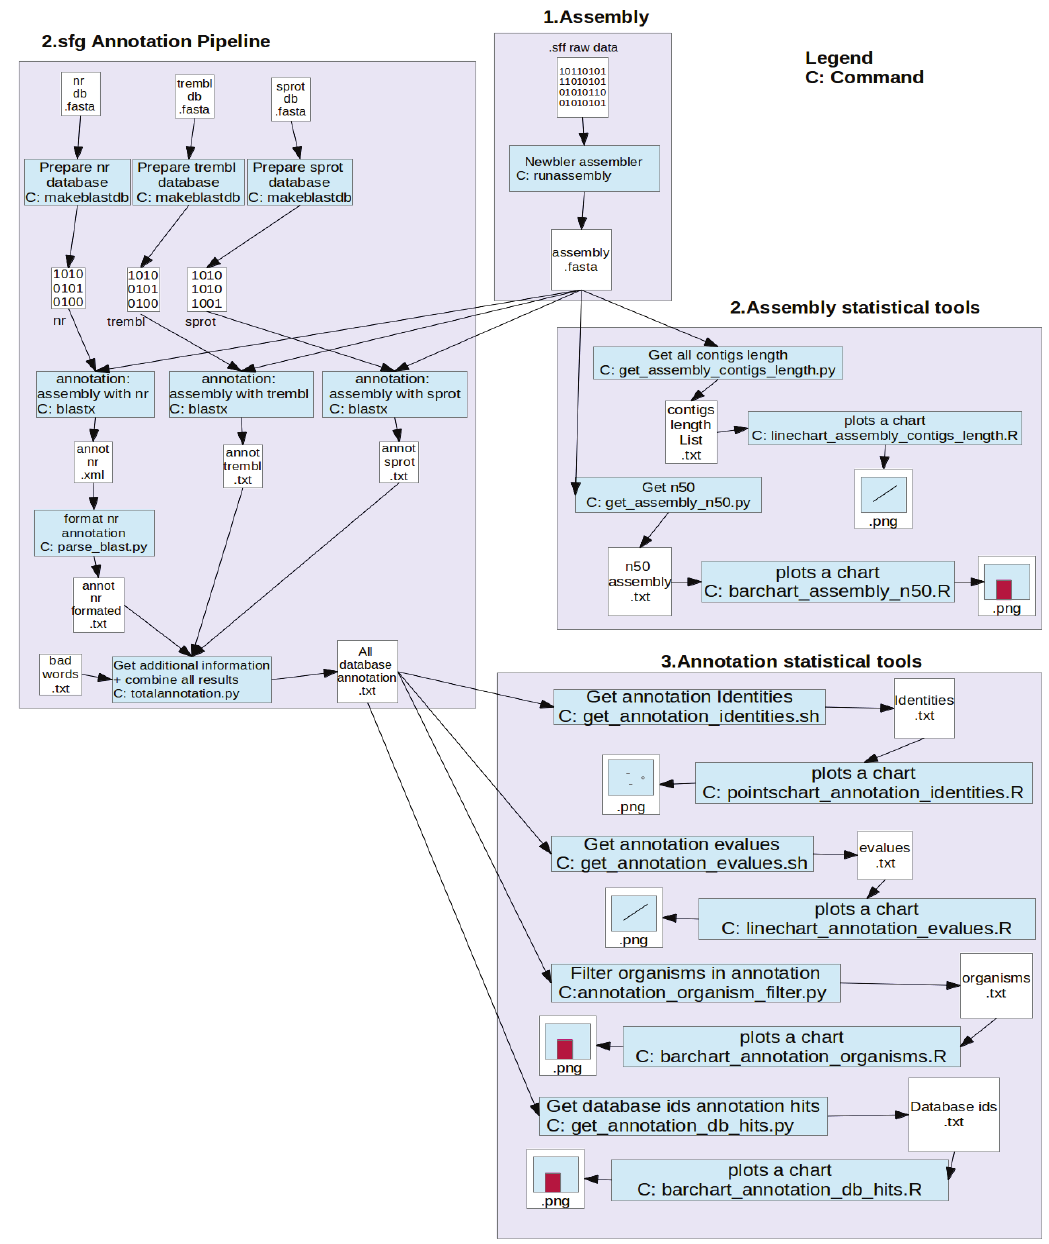
Figure 8: GITIRBio